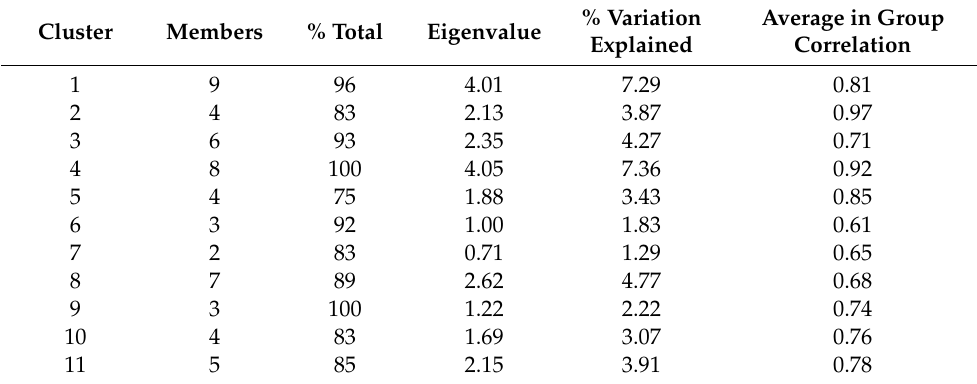
Table A2. Universality, strength, and consistency at class level.